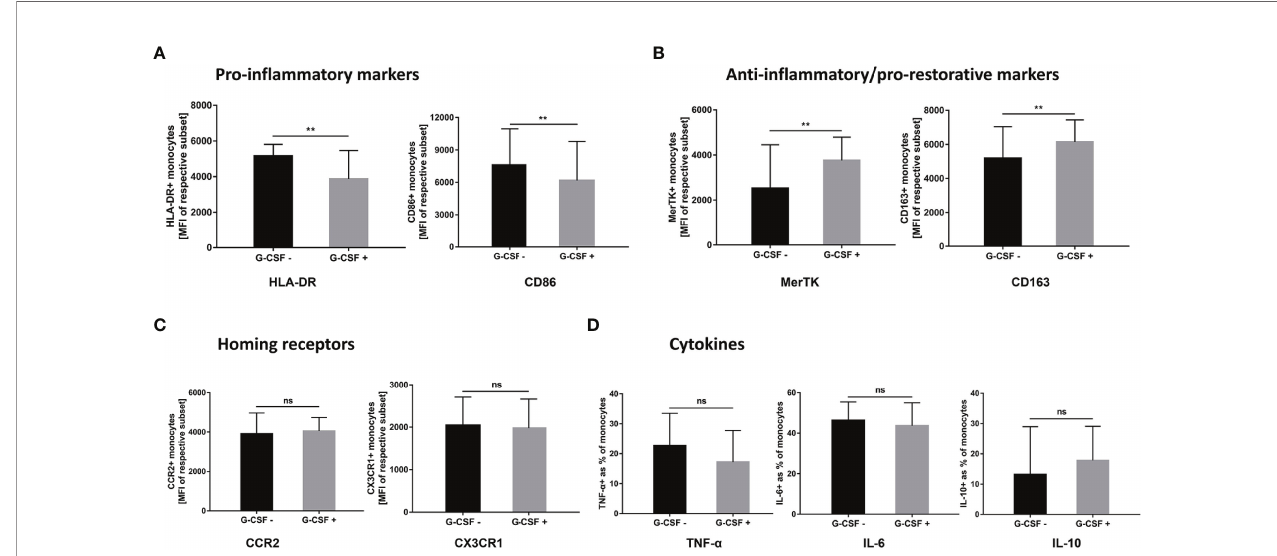
FIGURE 6 | G-CSF induces M2-like phenotype and functional transition of monocytes from HBV-ACLF patients in vitro . (A) G-CSF decreased the expression of pro-in fl ammatory markers on monocytes (n=9). (B) G-CSF elevated the expression of anti-in fl ammatory/pro-restorative markers on monocytes (n=9). (C) Effect of G- CSF on the expression of homing receptors on monocytes (n=9). (D) G-CSF attenuated pro-in fl ammatory cytokine secretion in monocytes (n=5). Non-parametric (Wilcoxon ’ s matched-pair test) statistical analysis was used. Data presented as median with interquartile range. ** represents compared with day 0, P <0.01; ns represents P > 0.05; G-CSF, Granulocyte-colony stimulating factor; HBV-ACLF, hepatitis B virus-related acute-on -chronic liver